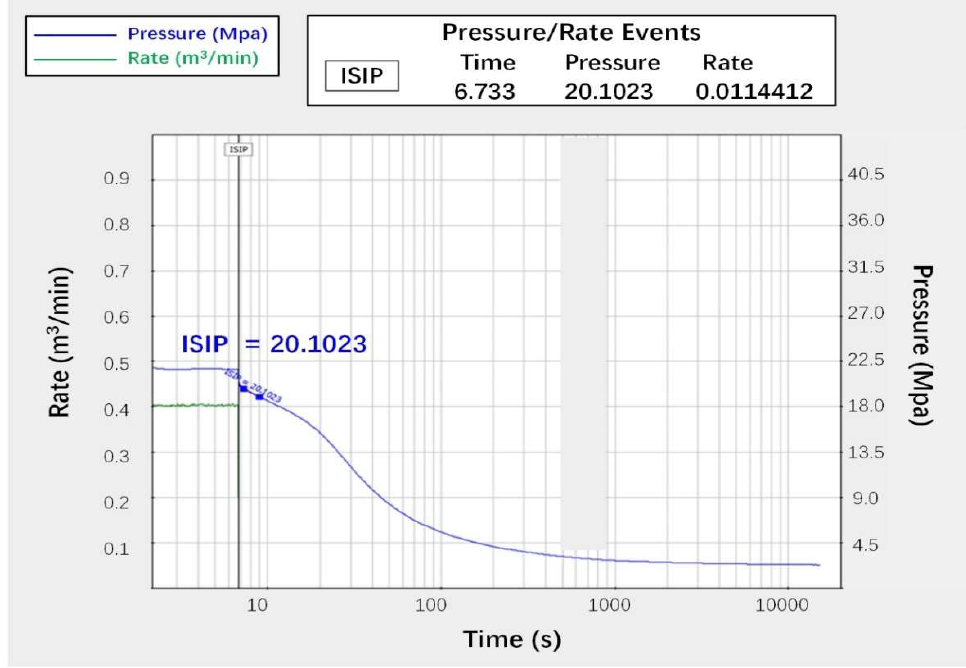
Figure 9. Surface pressure and rate changing for 10 days after pump shut down.